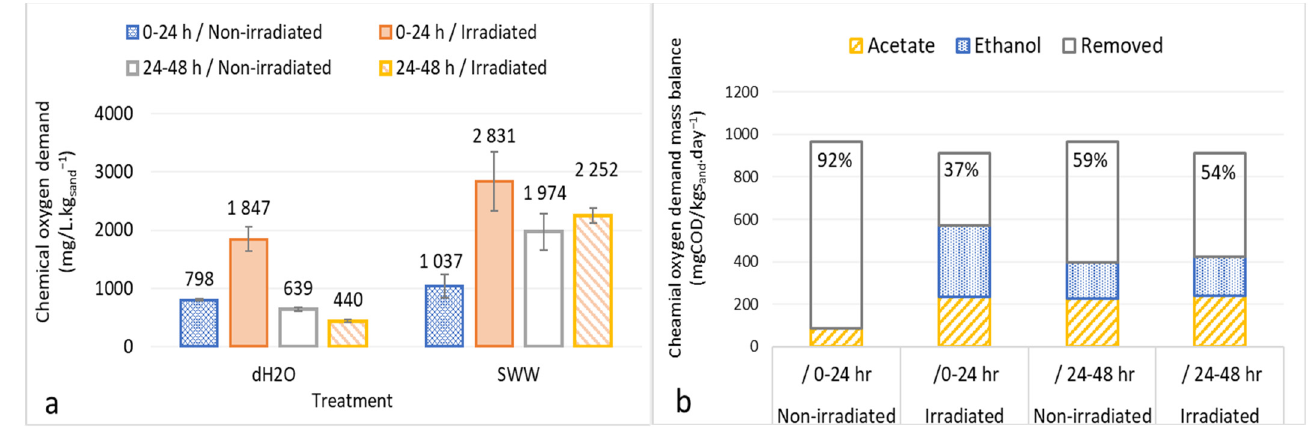
Figure 2. Specific chemical oxygen demand measurements for all the column replicates ( a ) and mass balance for ethanol and acetate added to the columns feed with synthetic winery wastewater ( b ).